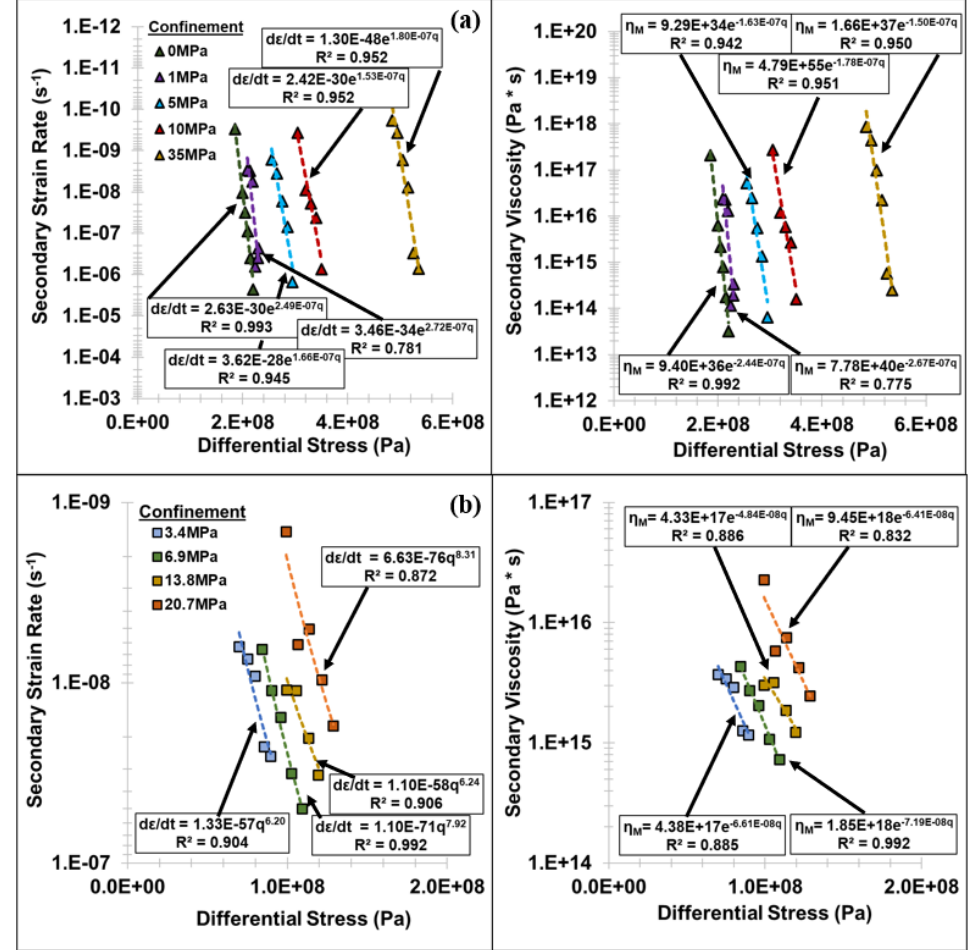
Figure 7. Secondary strain rates and associated Maxwell viscosities at varying levels of confinement for ( a ) LdB granite from [77], ( b ) Gyda sandstone from [91]. Note that η M denotes Maxwell viscosity, q is the deviatoric stress, and d ε /dt is strain rate.